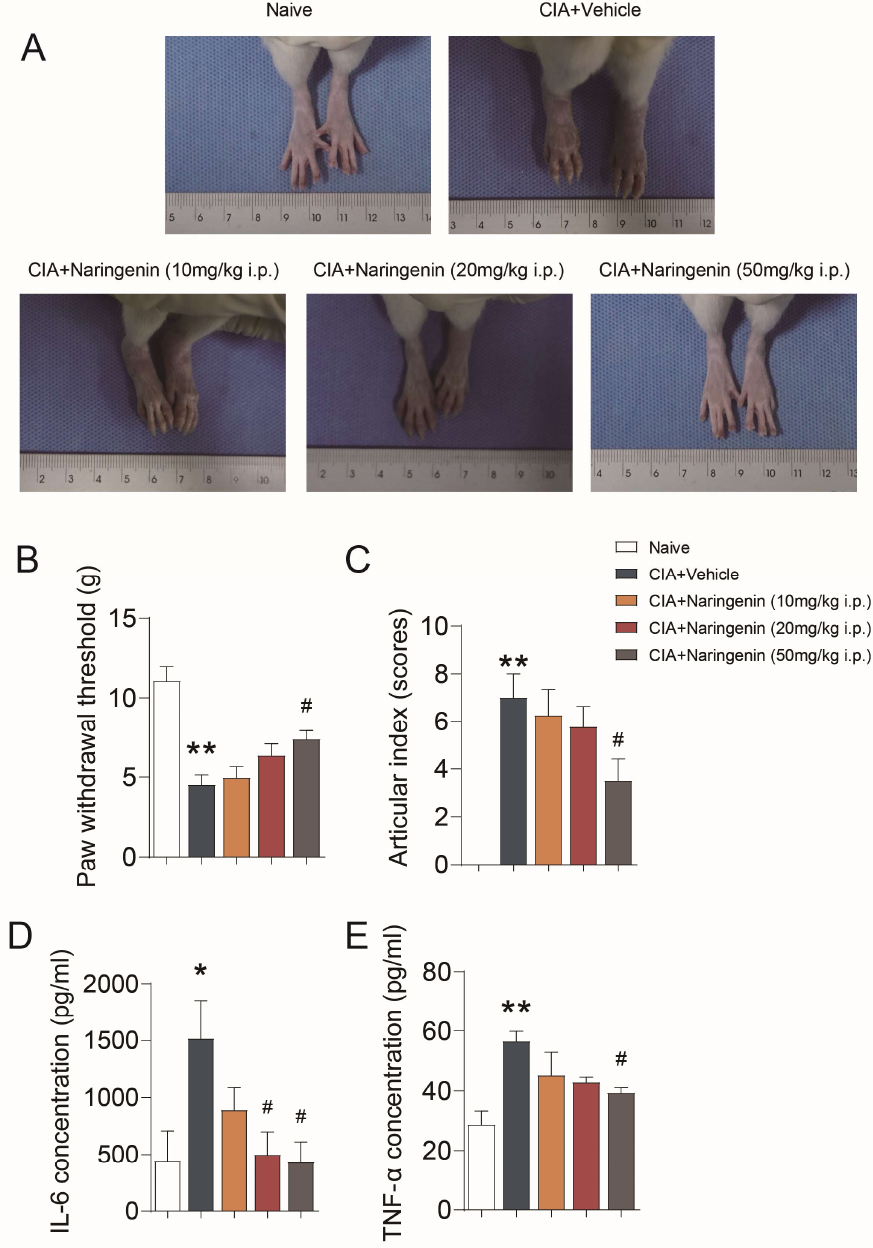
Figure 1. NAR improved pain-like behaviors and inflammation in CIA model rats. ( A ) The redness and swelling of the hind limbs seen in rats in different groups. ( B ) Mechanical pain threshold in CIA rats. ( C ) Arthritic score in CIA rats. ELISA was used to detect IL-6 ( D ) and TNF- α ( E ). * p < 0.05 vs. naive group, ** p < 0.01 vs. naive group. # p < 0.05 vs. CIA model group, by repeated-measures one-way ANOVA followed by post hoc Dunnett’s multiple comparisons test (n = 6–8 rats per group). In this and subsequent figures, the experimenters were blinded to the treatment